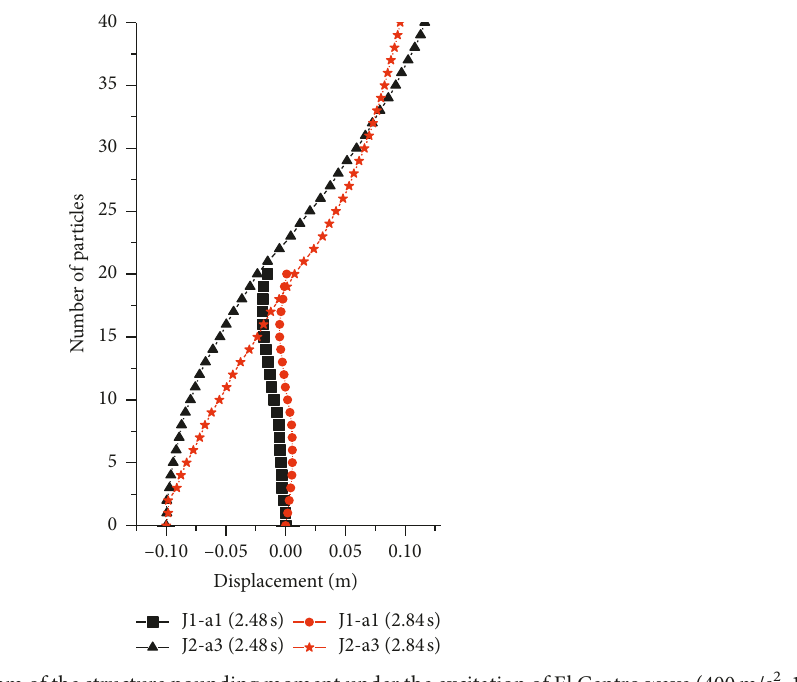
Figure 26: J 1 -a 1 , J 2 -a 3 deformation diagram of the structure pounding moment under the excitation of El Centro wave (400 m/s